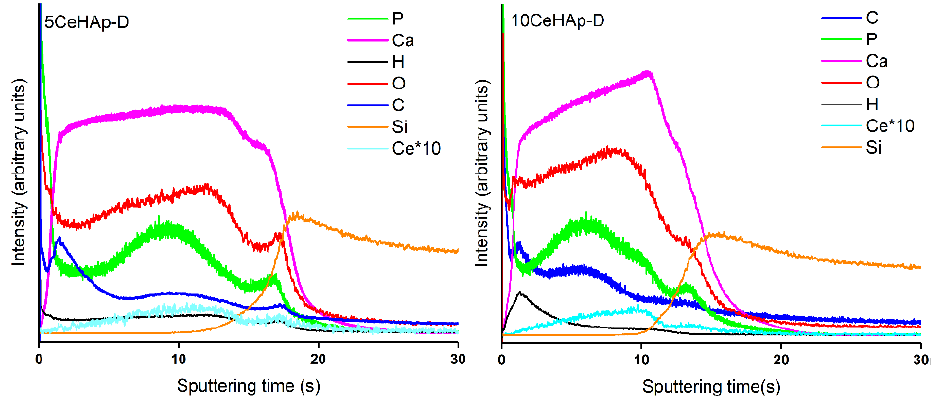
Figure 9. Compositional depth profiles of the 5CeHAp-D ( a ) and 10CeHAp-D ( b ) composite coatings obtained by GDOES.